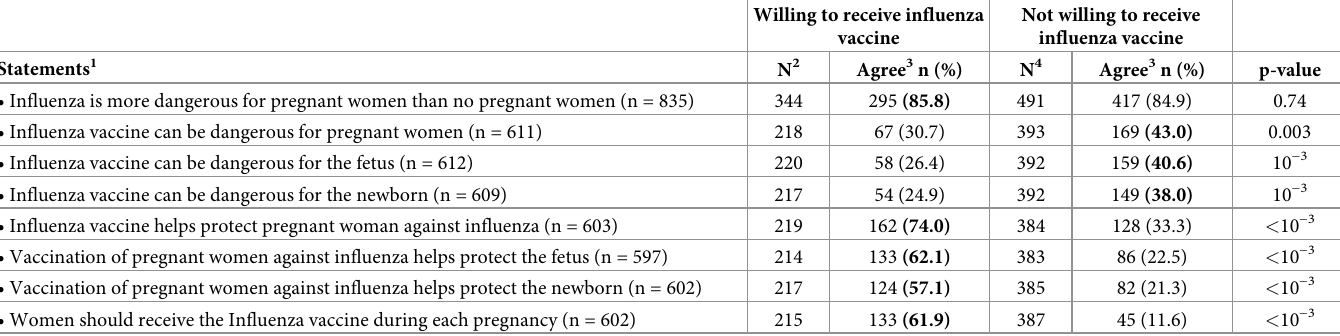
Table 3. Comparative analysis of knowledge and attitudes about influenza infection and influenza vaccination according to willingness to receive influenza vaccine during